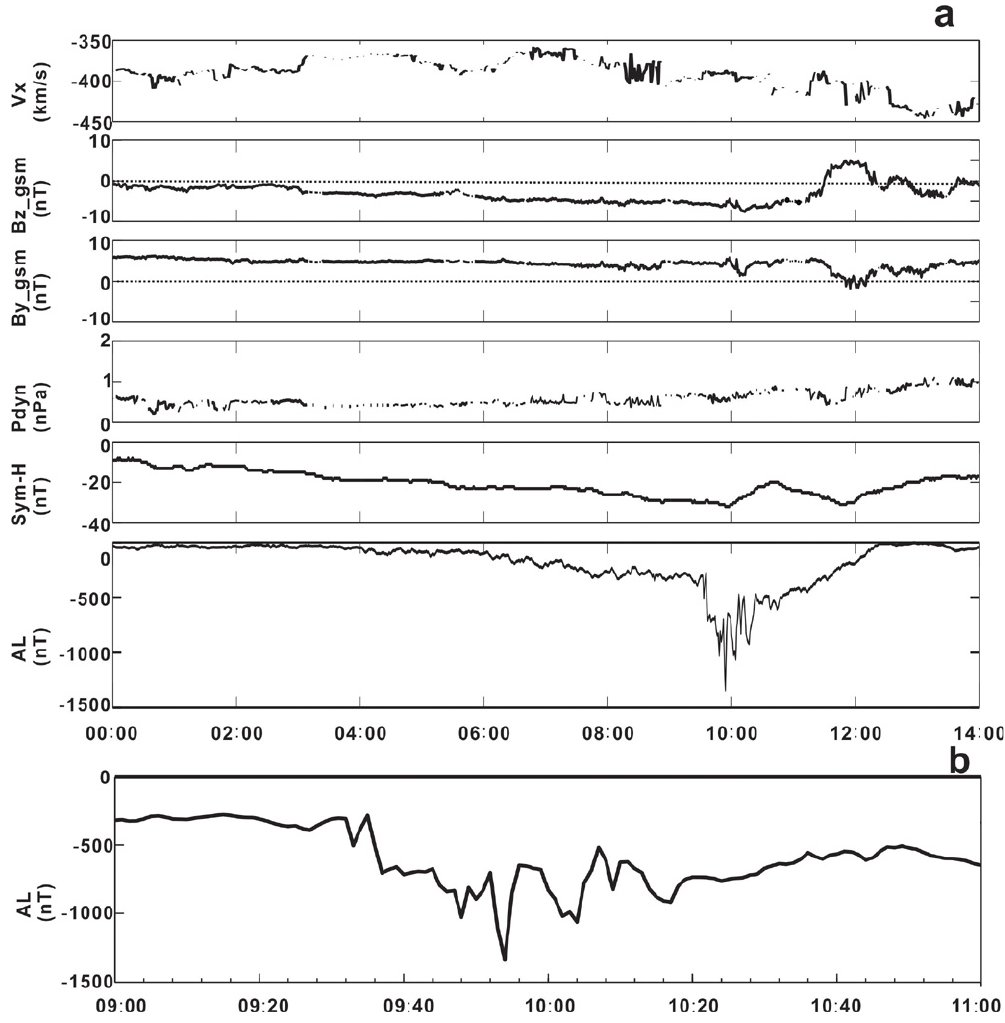
Fig. 2. (a) Stack plots of the solar wind parameters (including the solar wind speed, the B z and B y components of the interplanetary magnetic field in GSM coordinates, and the dynamic pressure), Sym-H index, and the AL index from 00:00UT to 14:00UT on 5 December 2008. (b) The AL index from 09:00UT to 11:00UT.